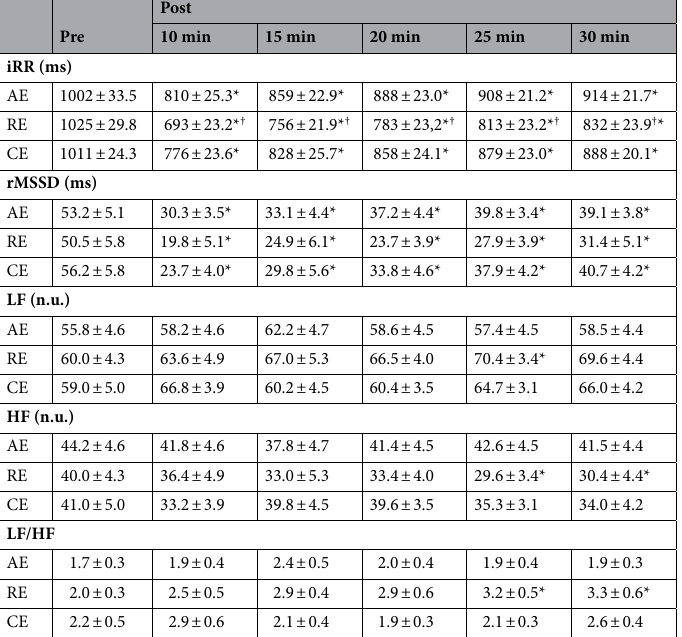
Table 2. Heart rate variability before and after exercise interventions. AE, aerobic exercise; RE, resistance exercise; CE, concurrent exercise; iRR, RR (inter beat) intervals; rMSSD, square root of the sum of successive differences between adjacent normal RR intervals; LF, low-frequency band; HF, high-frequency band; LF/HF, sympathovagal balance; BRS, baroreflex sensitivity. *Significantly different from pre ( p < 0.05). † Significantly different vs . AE at the same time point ( p < 0.05). Values expressed as mean ± standard